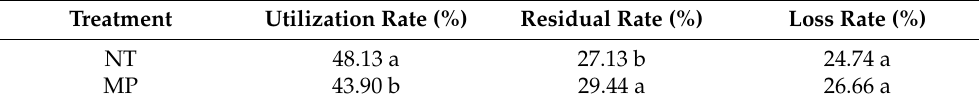
Table 3. Utilization of N fertilizer and residual loss under different tillage practices. Treatment Utilization Rate (%) Residual Rate